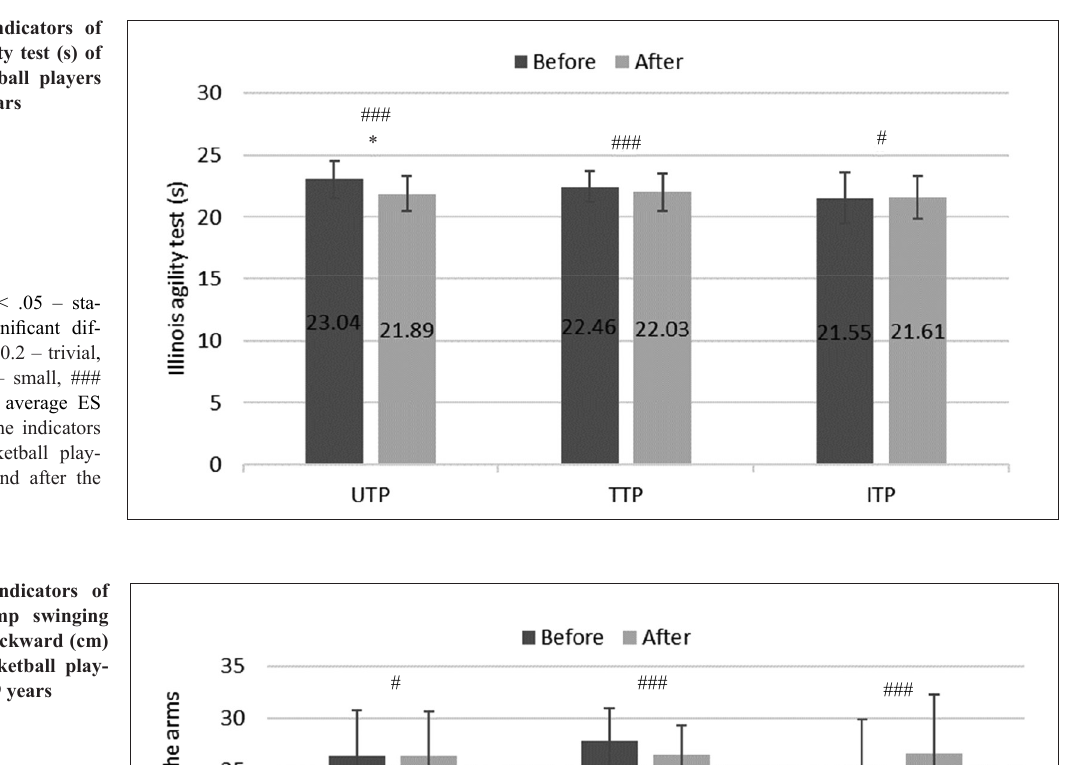
Figure 3. Indicators of Illinois agility test (s) of mini-basketball players aged 8–9 years